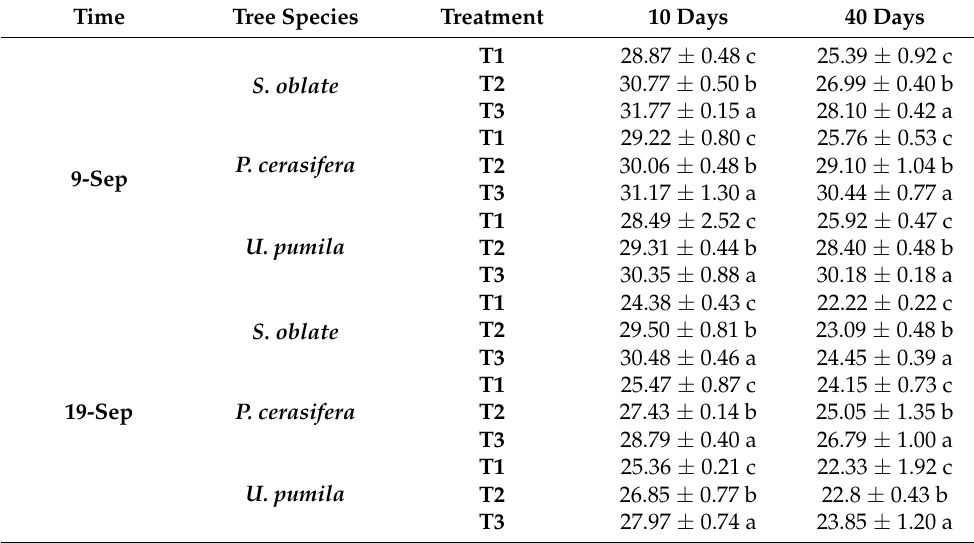
Table 4. Leaf temperature for three different SO 2 treatments (T1—T3) on 9 September and 19 September 2019 for S. oblate, P. cerasifera and U. pumila. Bars sharing a common letter are not significantly different ( p < 0.05). Bars represent means ± SE ( n = 9).